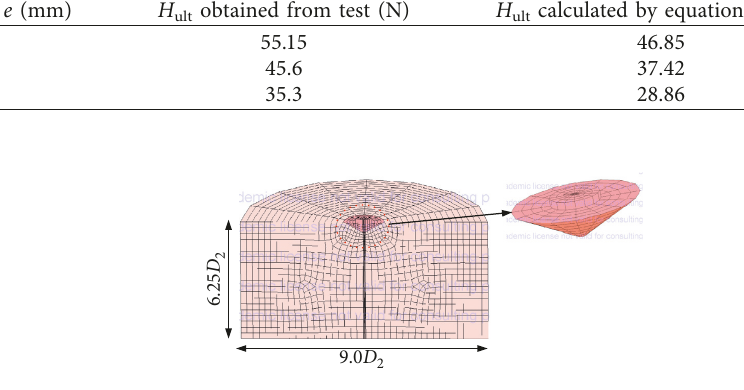
Figure 11: Finite element model.